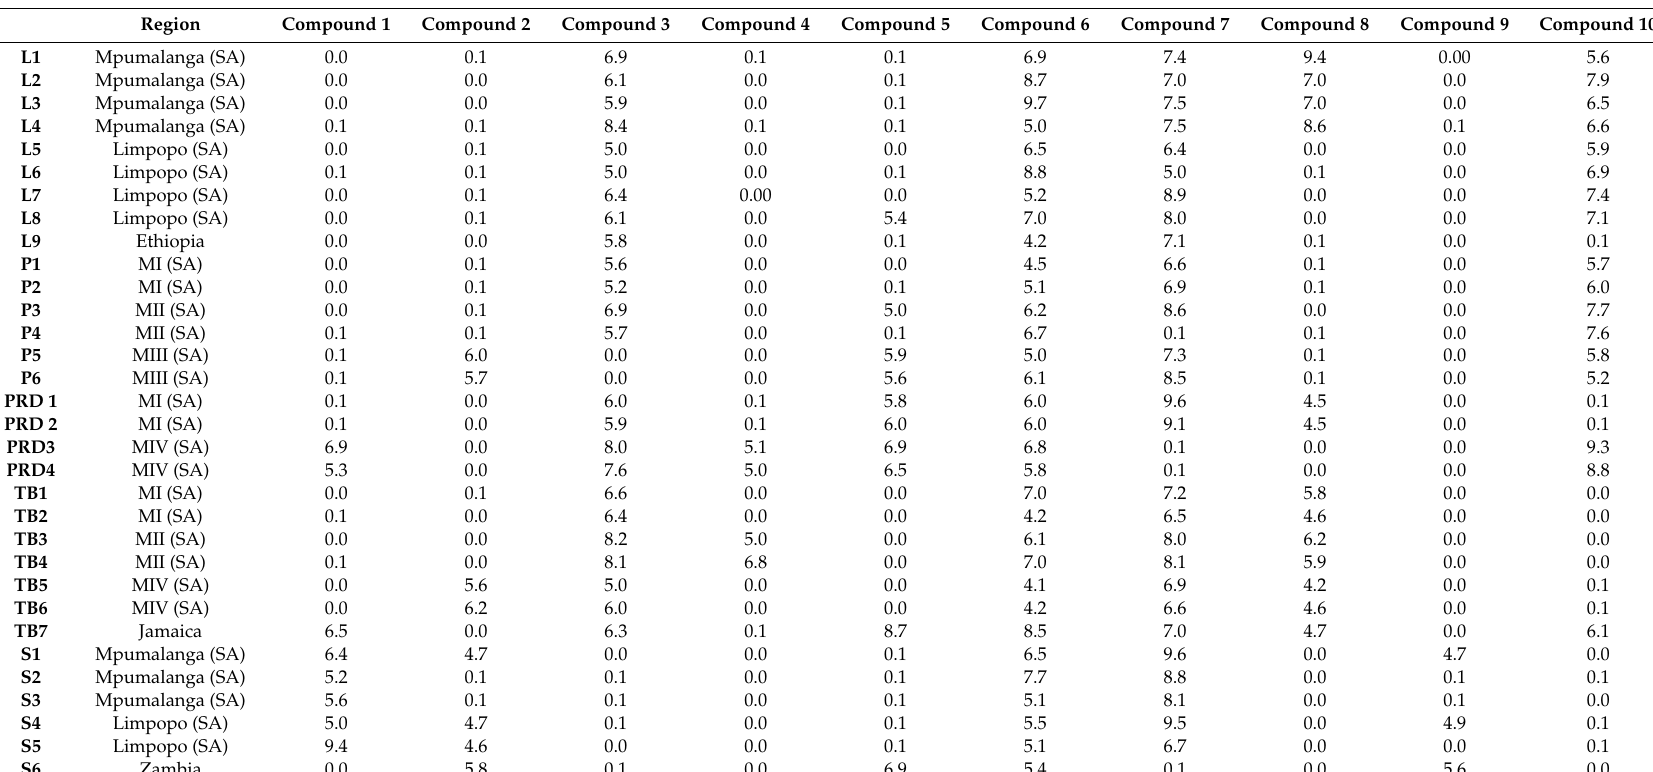
Table 3. Quantification data for application of the validated method to real samples (reported in mg kg − 1 of the compound per 280 mg kg − 1 of the